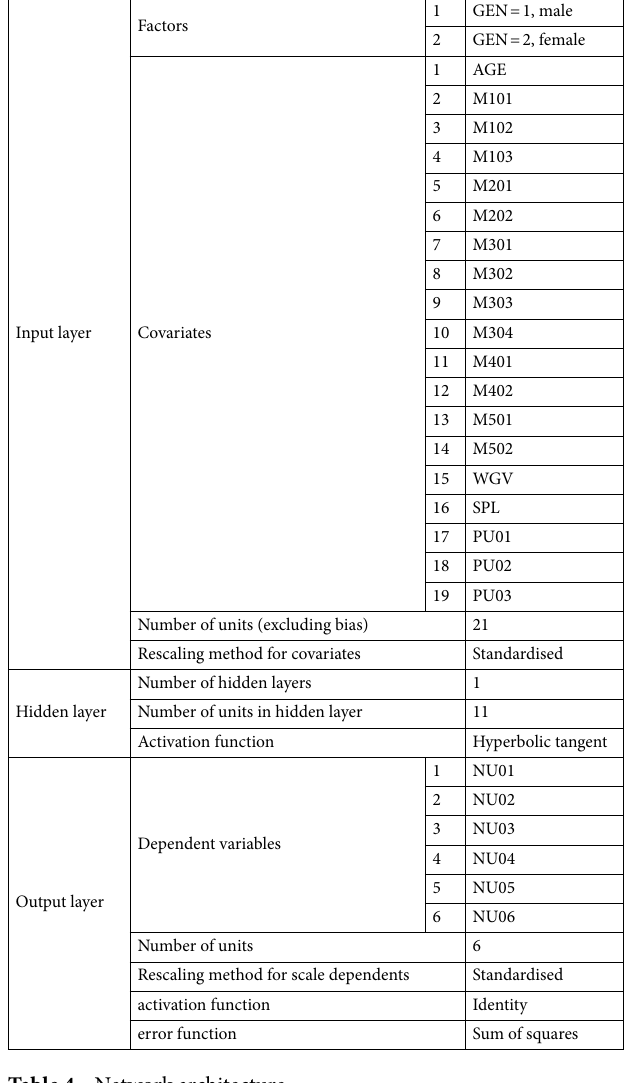
Table 4. Network architecture.